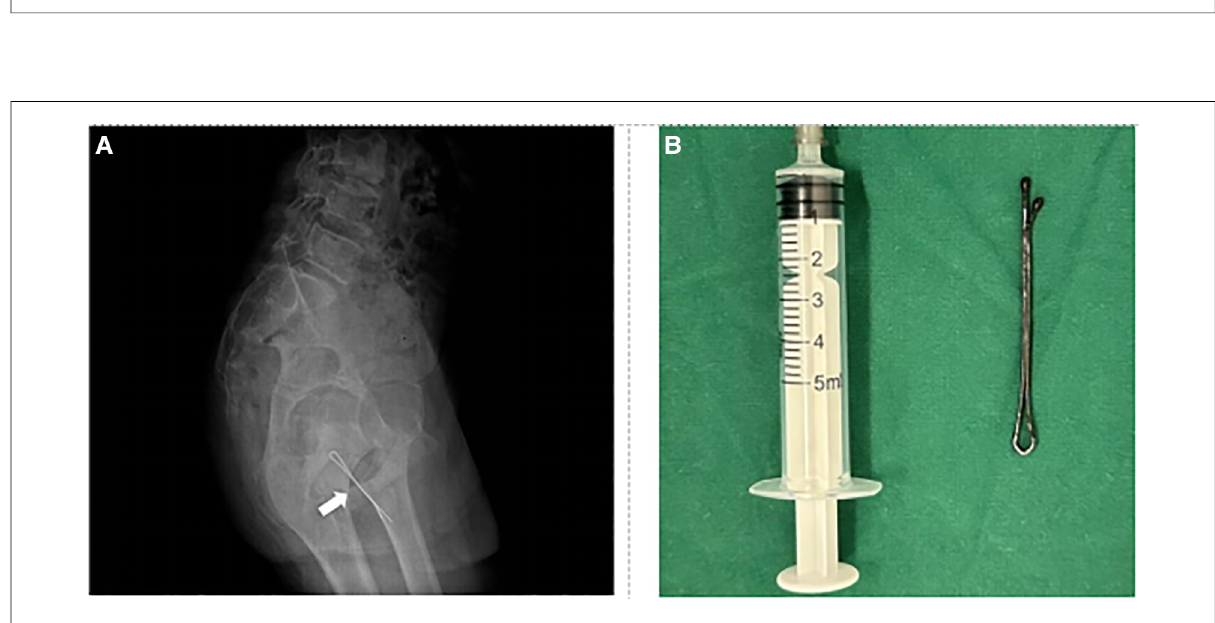
FIGURE 3 Preoperative imaging data and foreign body. ( A ) Plain fi lm x-ray shows multiple small spherical foreign bodies in the bladder (see arrow). ( B ) CT of the pelvis shows the massive foreign body in the bladder (see arrow). ( C ) Three-dimensional reconstruction CT shows the stripe foreign body in the bladder (red mark). ( D ) Foreign bodies are multiple magnetic beads (partly).